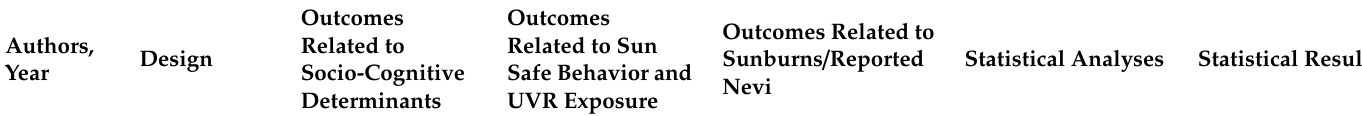
Table 3. Study outcomes and results of included studies in the systematic